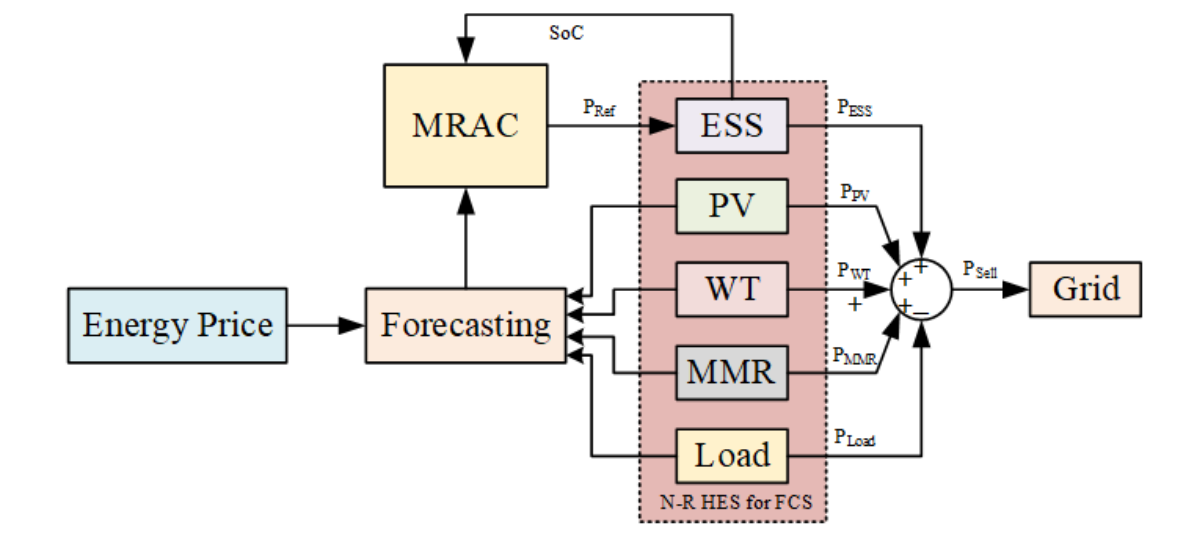
Figure 7. Illustration of the MRAC system with optimization